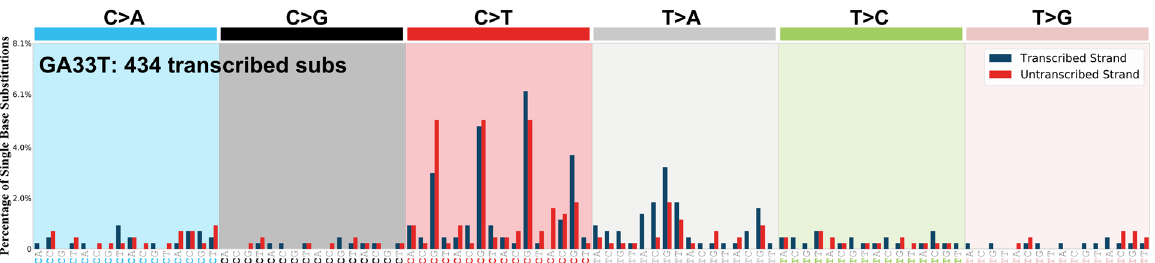
Figure 2. Mutational spectrum for GA33 with A to-T transversions with a weakly associated tran- scriptional strand bias in the C[T > A]G trinucleotide context.